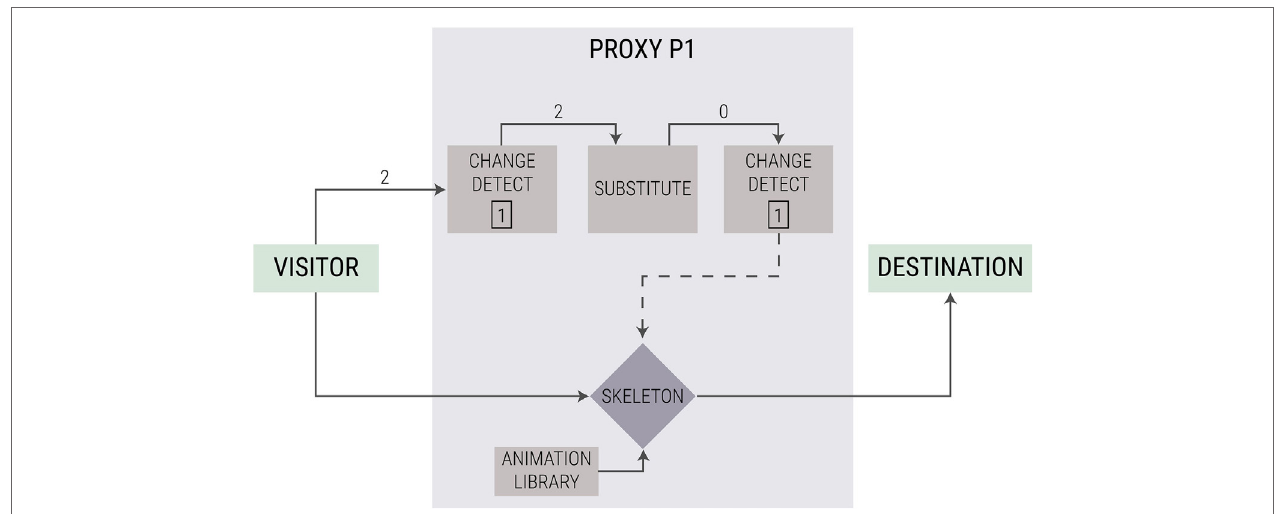
FigUre 2 | a simplified schematic diagram of a proxy handling transitions of the visitor among destinations